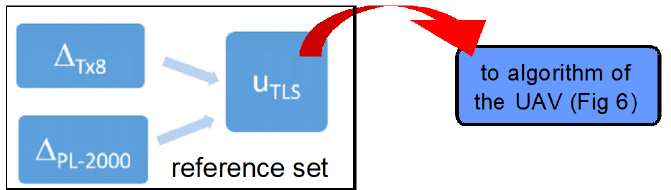
Figure 6. Algorithm for estimating the accuracy of the TLS method, where: ∆ TX8 , ∆ PL-2000 —absolute errors corresponding to the Trimble Tx8 laser scanner and PL-2000 national system, respectively, U TLS —uncertainty of the considered method.